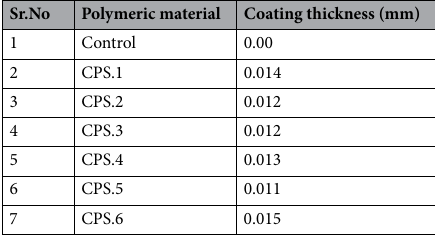
Table 4. Thickness of Coatings.